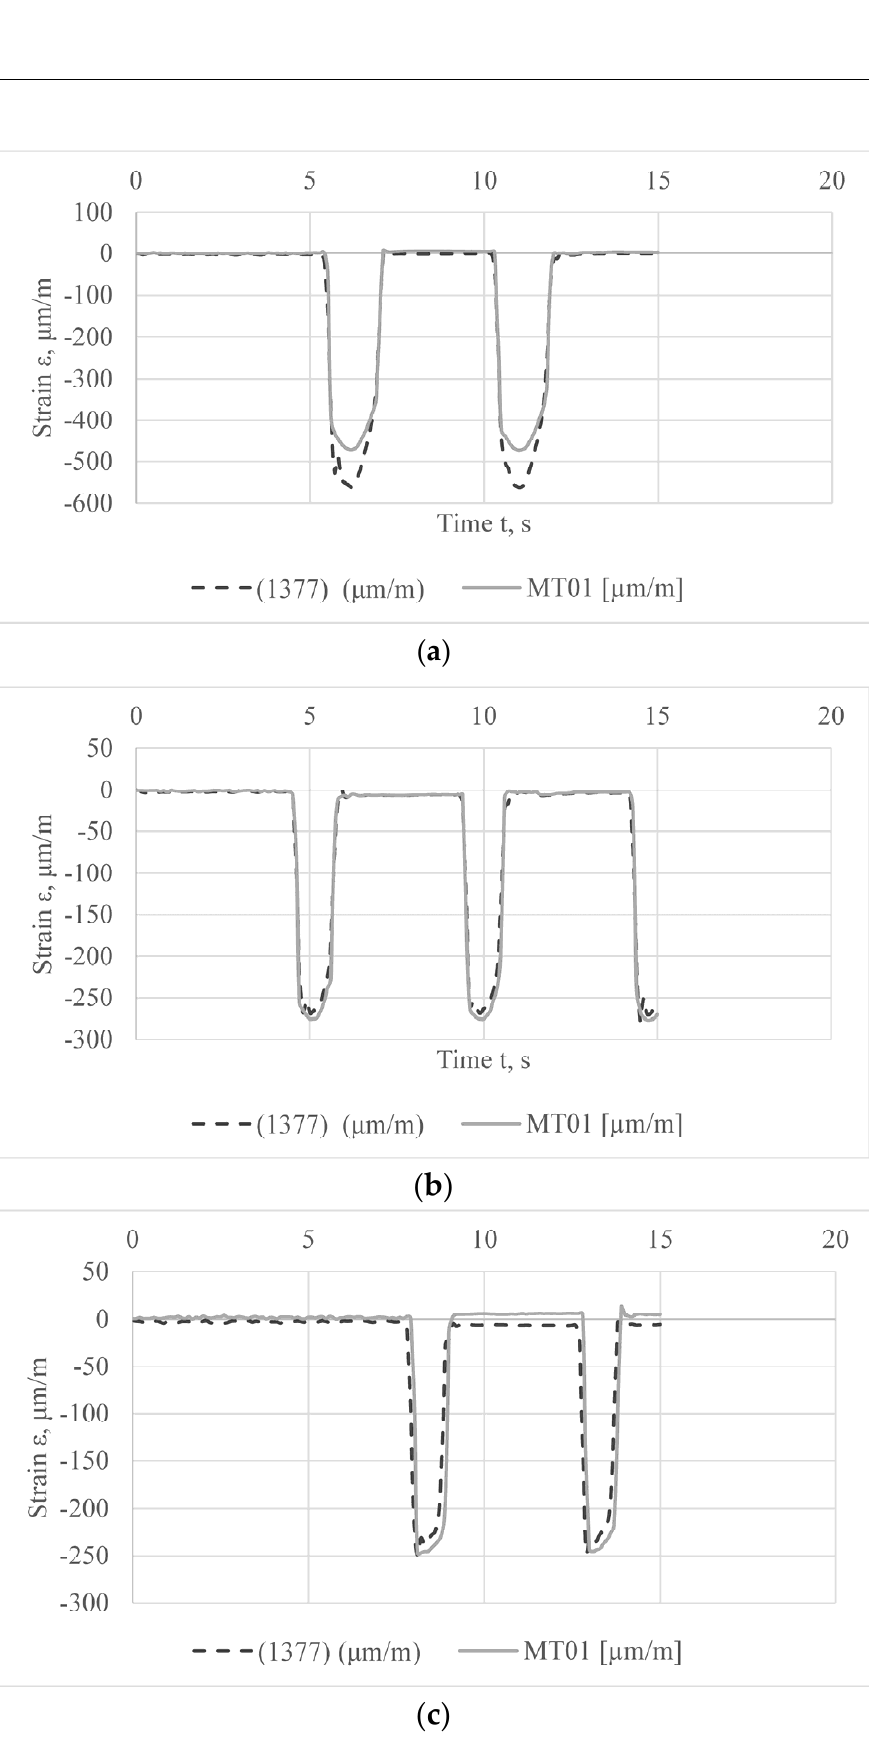
gear. This is found in both numerical and experimental analyses. The di ff erence in stresses between the double-tooth and the triple-tooth meshing is much smaller than between the single-tooth and the double-tooth meshing. A correlation analysis was conducted for the presented diagrams. The single tooth meshing results correlates 99.6% between the exper- imental and numerical results. The double-tooth and triple-tooth meshing results corre- late 99.7% and 92.9% between the experimental and numerical results. The biggest devia- tion in correlation was the triple tooth meshing case because of the multiple meshing con- tacts and harder input force prediction. The correlation analyses show that the simulation setup follows the experimental procedure in more than acceptable boundaries. The high- est stresses occur in the simulations and experiments at the site of strain gauge 1 or node 1377. Figure 11 gives a comparative diagram of the strains at the site of strain gauge 1. Based on Figure 11, it can be concluded that the di ff erence in the strain values is almost negligible in the double-tooth and triple-tooth meshing, while the strain values for the single-tooth meshing di ff er considerably. Namely, in the case of the triple meshing, the strain values obtained by numerical analysis are slightly lower compared to the values obtained experimentally. The lowest strains occur at the site of strain gauge 5 in the ex- perimental analysis, while in the numerical analysis, the lowest strains occur at strain gauge 6. In the numerical analysis, the strain values are much higher at the sites of strain gauges 4 and 5, while at the site of strain gauge 6, the stress values are lower. This is not the case with other strain gauges. This inconsistency may be caused by improperly glued strain gauges or inhomogeneity of the cycloid disc material, among other reasons. The deviations between the numerical and experimental analysis results for the strain gauge